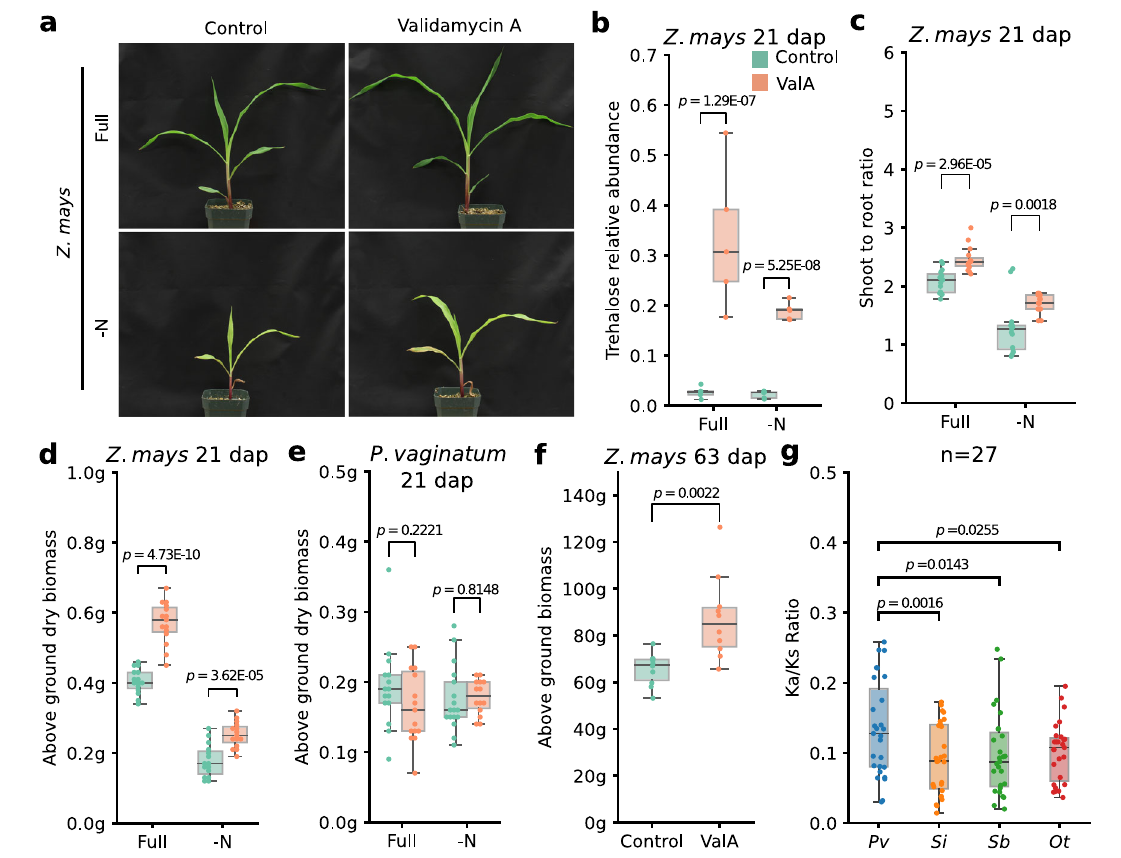
Fig. 4 | Validamycin A treatment is associated with increased trehalose accu- mulation and greater biomass production in maize. a Representative images showing maize seedlings at 21 days after planting (dap) grown under Full and -N conditions combined with validamycin A treatment (ValA) or without (Control). b Changes in trehalose abundance in root tissue in response to validamycin A treatment across conditions. N =5 biological replicates each consisting of pool tissue. c Changes in the ratio of shoot-to-root dry biomass in 3-week-old maize seedlingsgrownacrosstreatmentsandconditions. N =15independentlymeasured plants grown across three distinct experiments. d , e Changes in the above ground dry weight of three week old maize and paspalum plants across treatments and